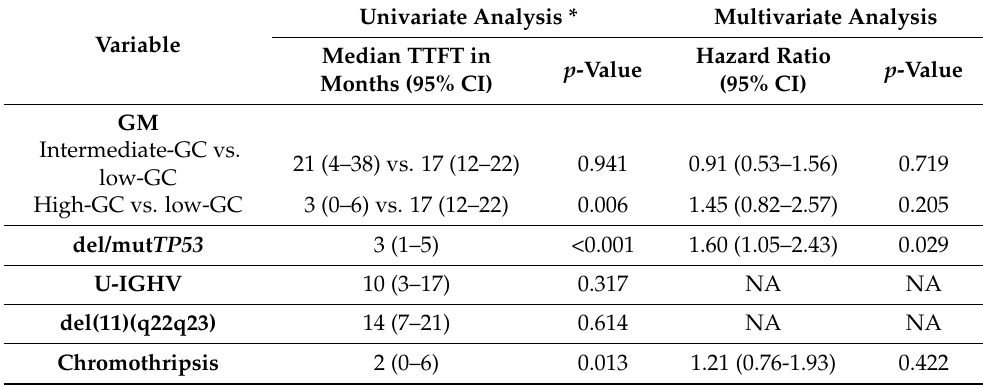
Table 2. Univariate and multivariate analysis for time to first treatment